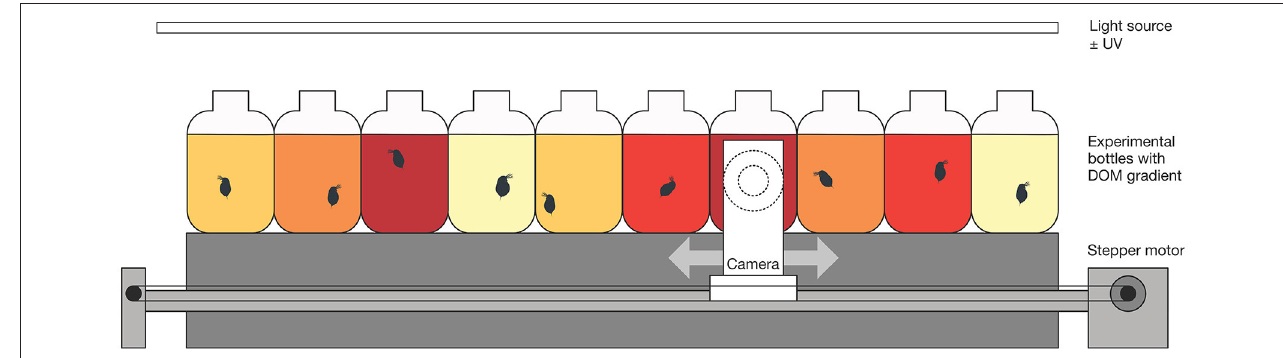
FIGURE 1 | Schematic overview of the experimental design. For each experimental run, every DOM concentration (color gradient) was present in duplicates and randomly placed in front of the camera axis. Each flask contained a single Daphnia magna neonate. For details on the experimental procedure and filming regime, see the Materials and Methods